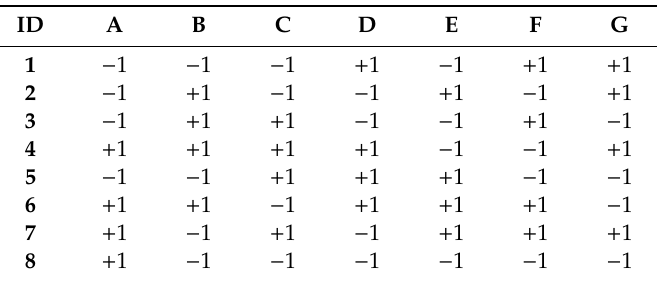
Table 1. Plackett–Burman experimental